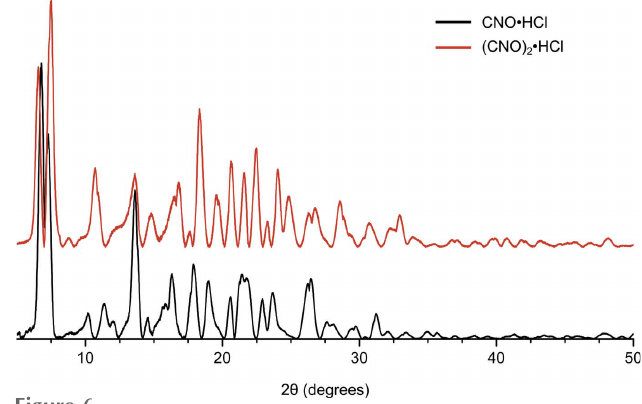
Figure 6 Overlay of powder patterns of the initial precipitate of (CNO) (cid:2) HCl and the recrystallized material (CNO) 2 (cid:2) HCl.